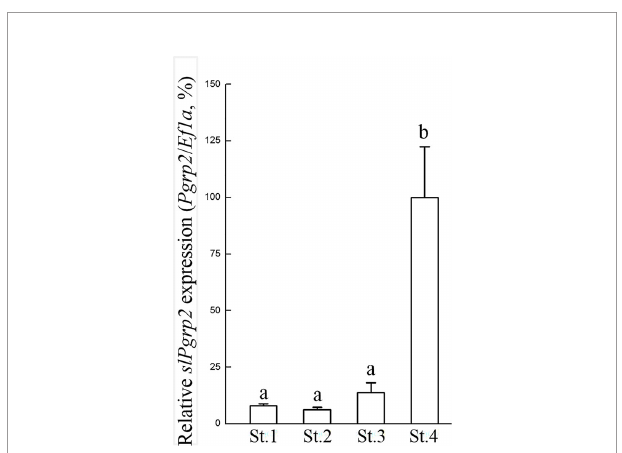
FIGURE 5 | Gene expression pro fi le of slPgrp2 during ANG growth. According to histology, four different stages of ANGs were used for gene expression analysis, including stage 1 (n = 4), stage 2 (n = 14), stage 3 (n = 12), and stage 4 (n = 9). The expression pro fi le of slPgrp2 during ANG development was analyzed by qPCR. Different lower-case letters indicate signi fi cant differences between stages of ANGs ( P < 0.05). St,